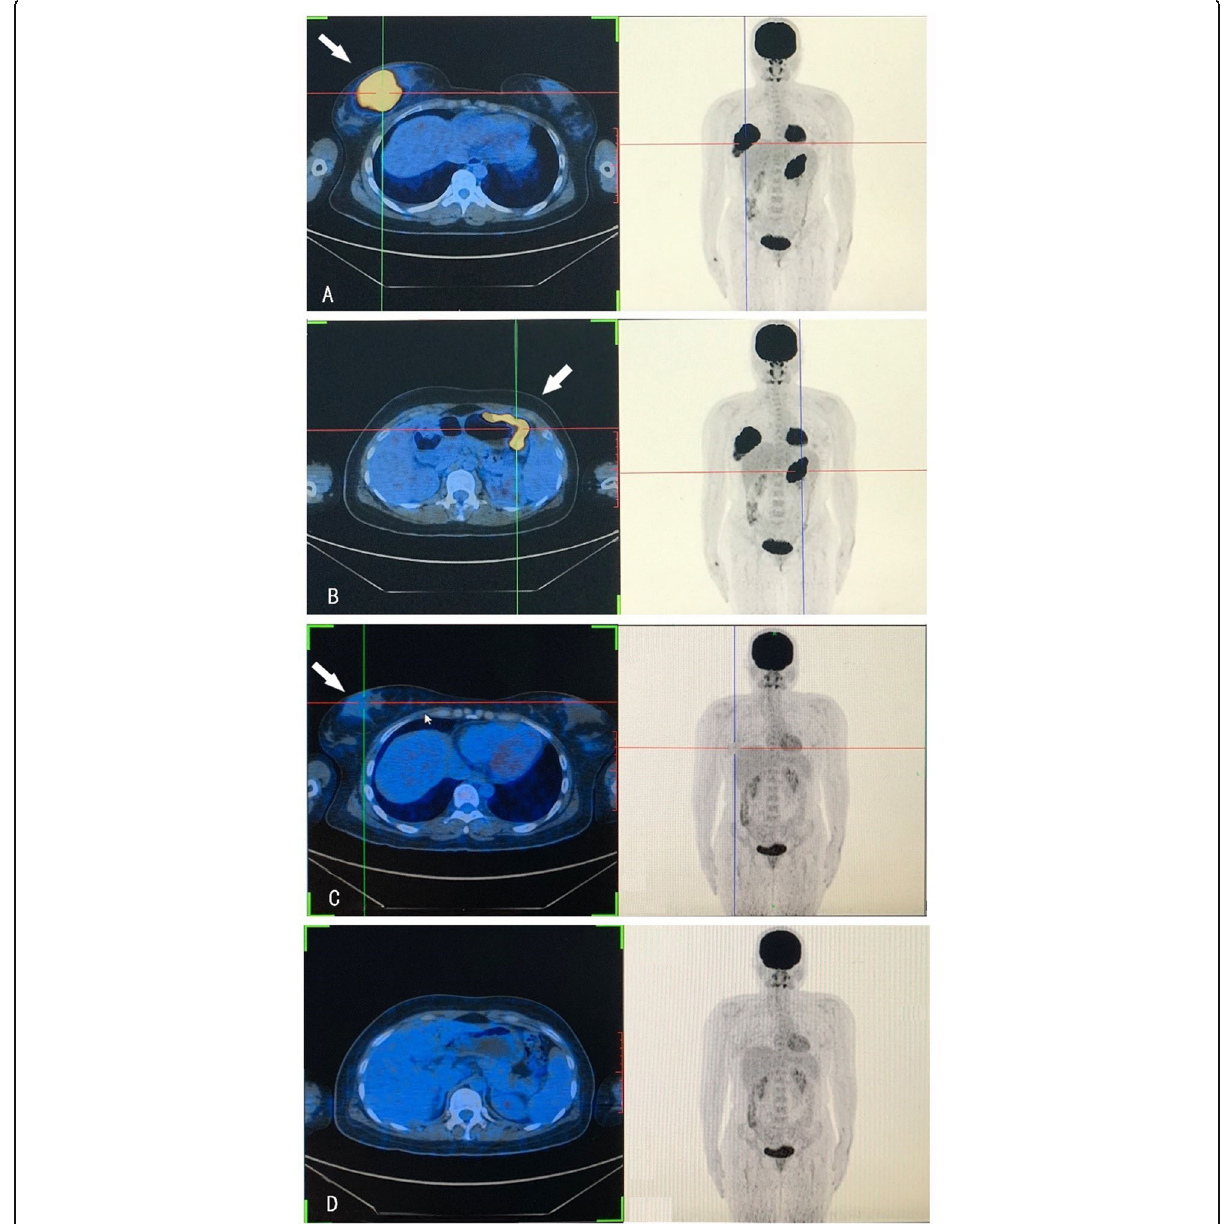
Fig. 1 A whole-body positron emission tomography (PET)-CT scan revealed intense FDG uptake in the right breast (A) and greater curvature of the stomach (B). After four cycles of modified SMILE regimen, the right breast mass was significantly smaller than before (C). FDG uptake in the stomach wall disappeared